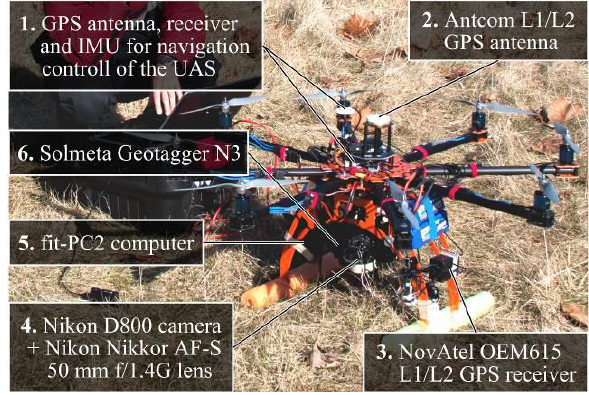
Figure 1. Bergen octocopter at test